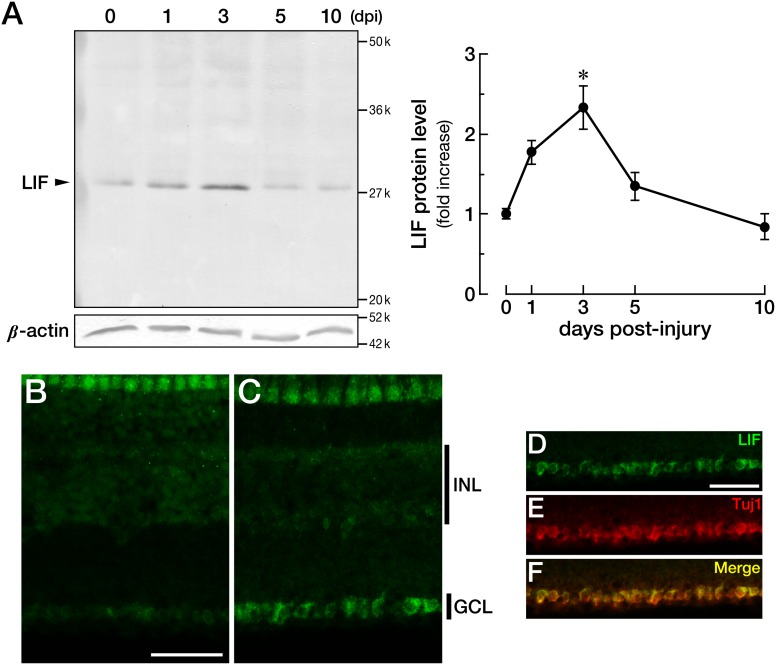
Upregulation of the LIF protein in zebrafish RGCs after optic nerve injury.(A) As with the expression changes of LIF mRNA, the LIF protein was also upregulated starting on day 1 after the optic nerve injury, peaked at 3 days, and returned to baseline by 5 days post-injury (n = 3, *p<0.001). (B, C) Immunohistochemical analysis of the LIF protein expression revealed that LIF was upregulated mainly in GCL at 3 dpi (C) compared with the intact retina (B). (D–F) Double immunohistochemical staining of LIF (D) and Tuj1 (E) revealed that LIF is produced in RGCs (F). The scale bars in (B) and (D) are 30 µm.